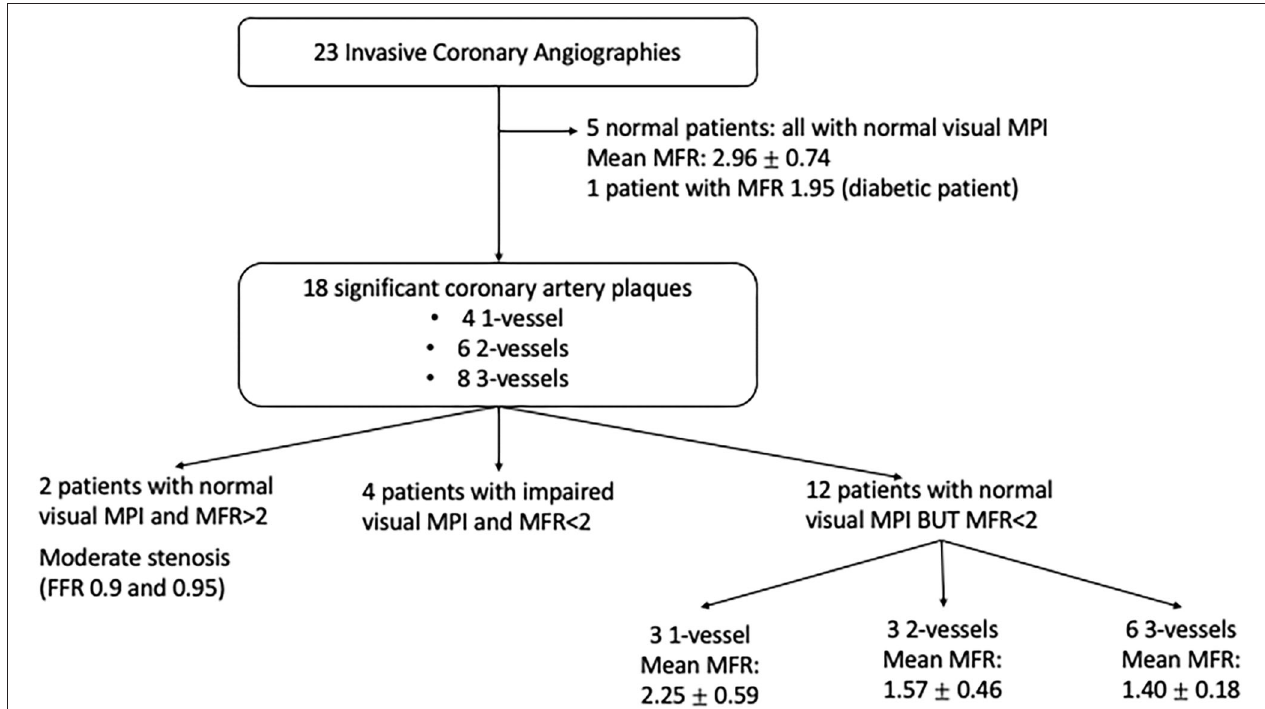
Global-based analysis Vessel-based analysis Without CAD With CAD p Without CAD With CAD p